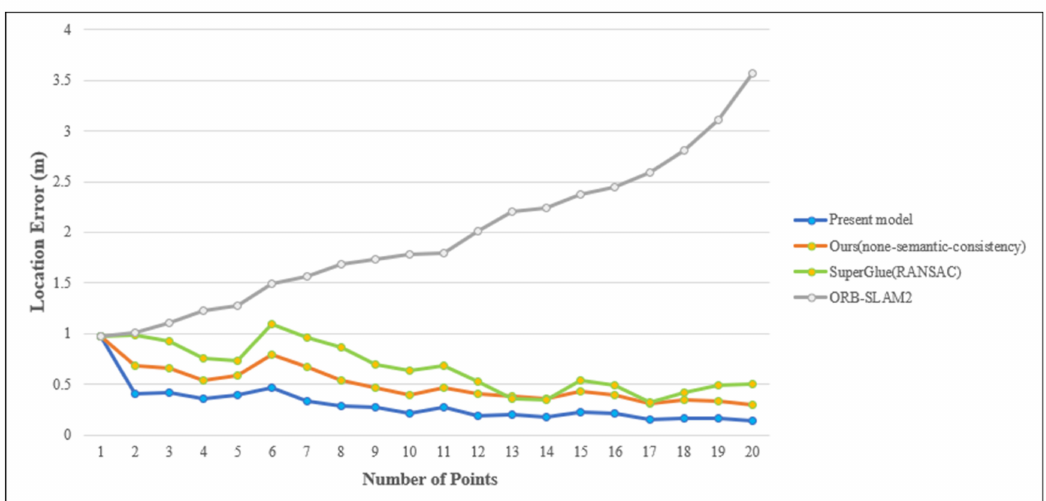
Figure 7. Location error obtained for the self-collected data.